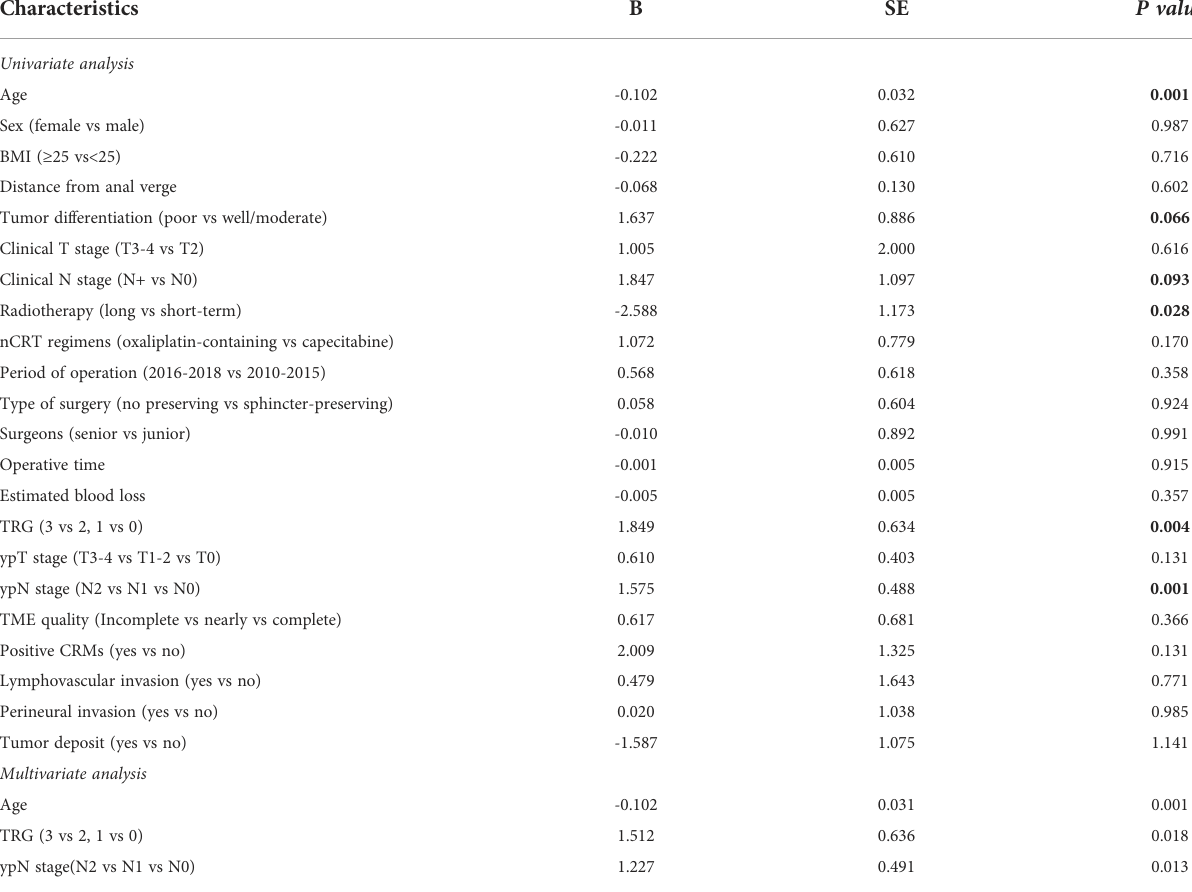
TABLE 4 Analysis of the association between characteristics of patients and the number of lymph nodes harvested.